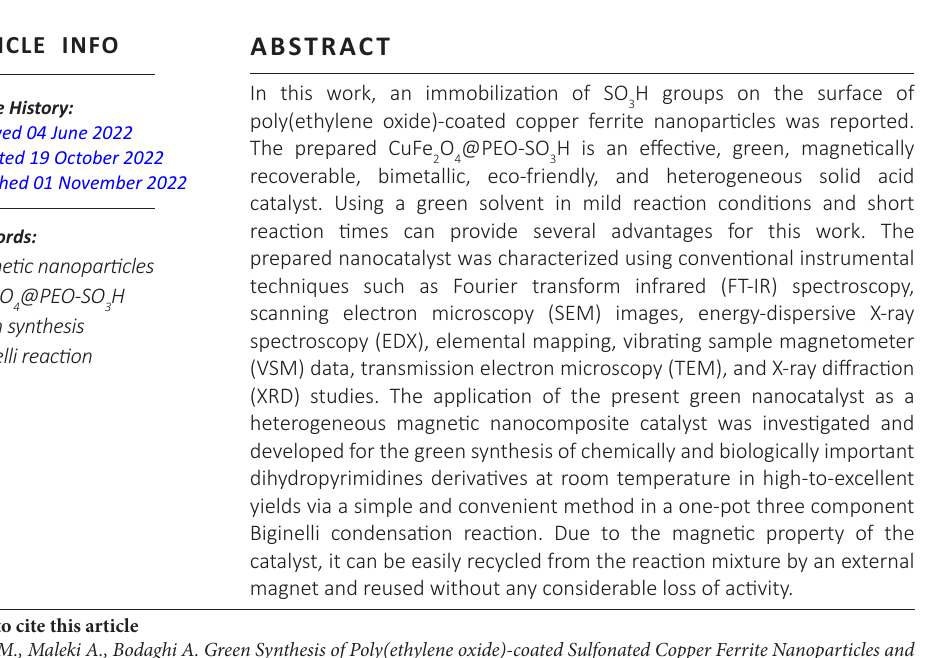
Table 3. A comparison of the effects of some catalysts with that of the present nanocatalyst on the model reaction. Ref. Yield a (%) Time Temperature (°C) Catalyst